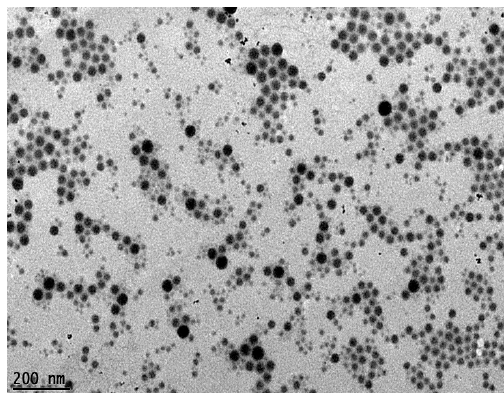
Figure 2. Spherical oil droplets of TRF nanoemulsion prepared with emulsifier blend Span 80:Brij 35 (0.4:0.6 w / w ) at a concentration of 2.5% w / v homogenized by microfluidizer (25,000 psi, 10 passes) viewed under transmission electron microscopy (TEM).